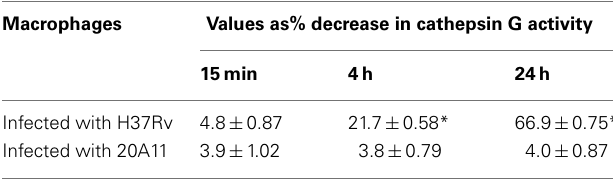
Table 4 | Inhibition of cathepsin G in M. tuberculosis 20A11-infected macrophages reduces caspase-1-induced